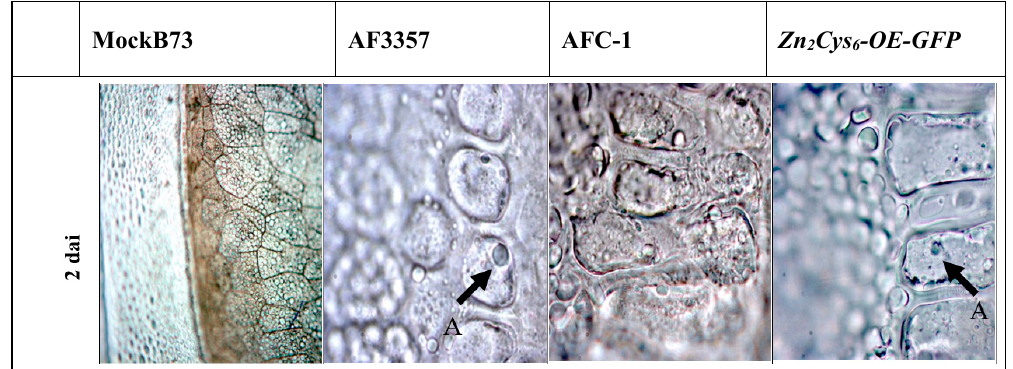
Figure 2. TUNEL assay at 2 dai in all the studied strains: MockB73, AF3357 (wild type); AFC-1 ( − pyrG , − argD mutant); Zn 2 Cys 6 -OE-GFP (overexpressing the transcription factor). In all three cases, the cells belong to the aleuronic layer. This assay shows apoptotic (A) nuclei in blue indicated by the arrows. Magnification 1000×.